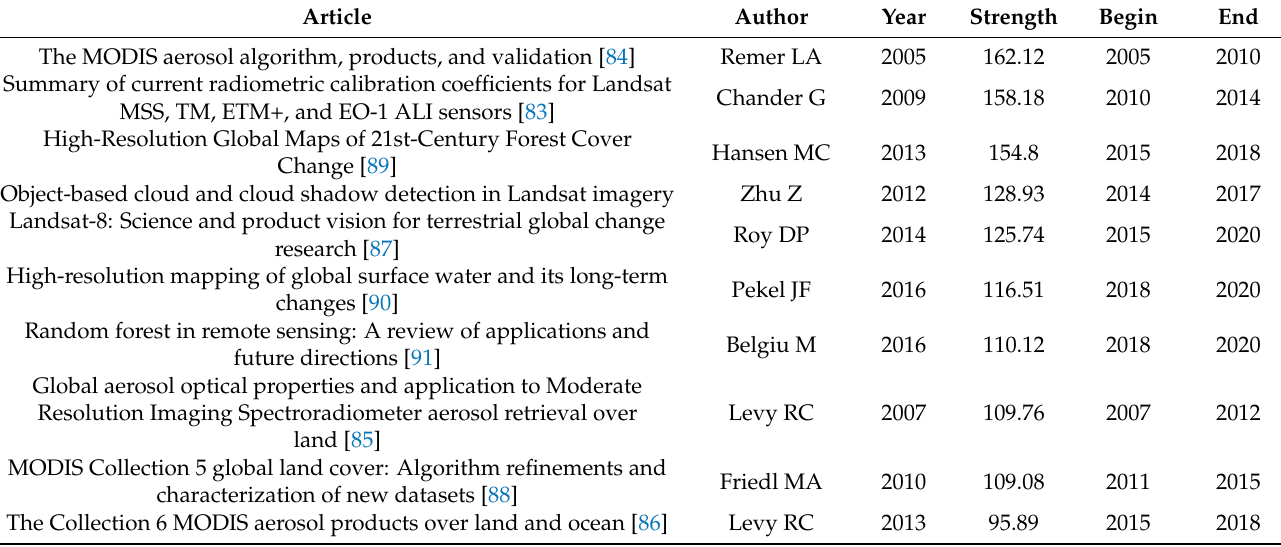
Table 3. EO papers with the strongest citation